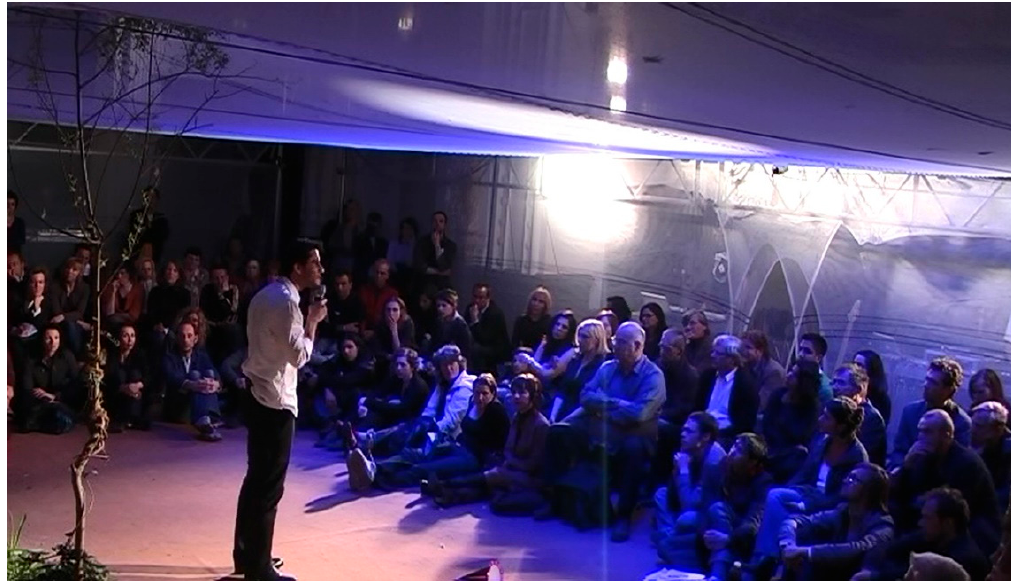
Figure 1. Nathan, played by Murat Seven, addresses the audience (screen capture from the DVD of the 2009 performance at the Ballhaus Naunynstraße in Berlin).